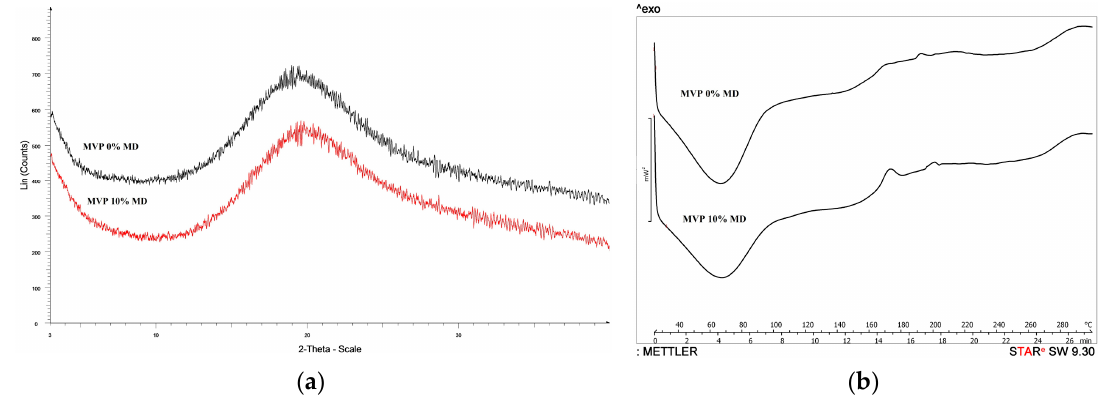
Figure 4. ( a ) XRPD patterns of the 0% MD MVP and 10% MD MVP; ( b ) DSC curves of the 0% MD MVP and 10% MD MVP .